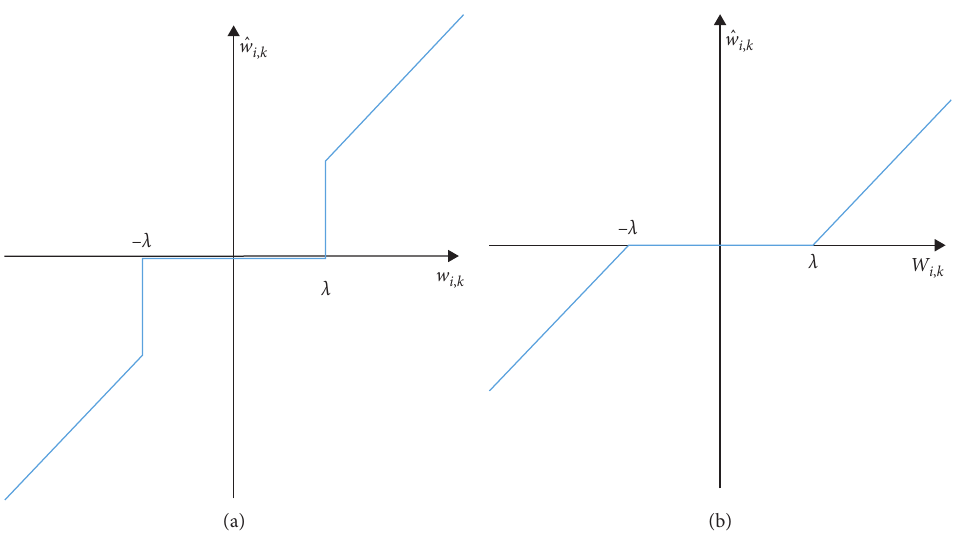
Figure 3: Traditional wavelet threshold function. (a) Hard threshold function. (b) Soft threshold